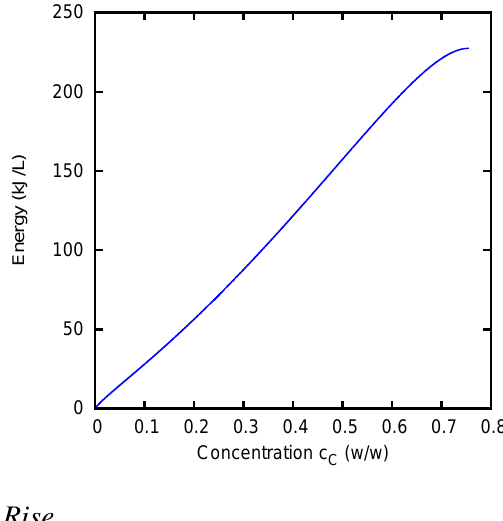
= 75 : 5 %, A = c . The step of the cycle in dilute solution starts D A = 0 , and stops at a concentration c B C